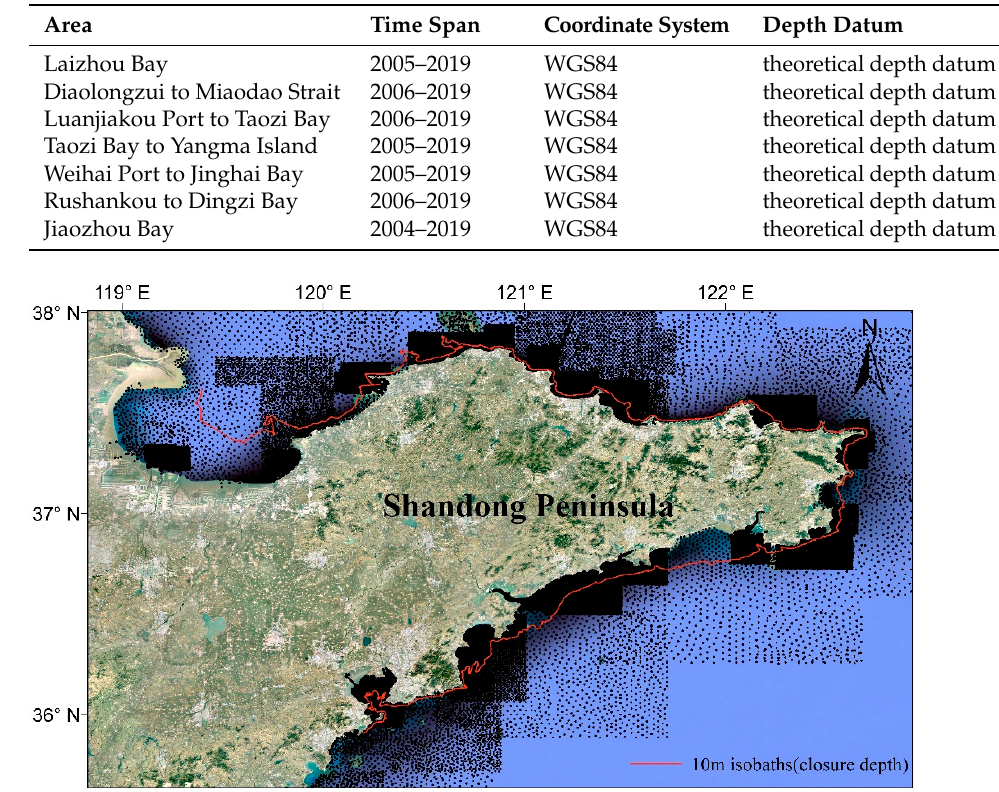
Table 1. Depth data of coastal waters in the Shandong Peninsula.